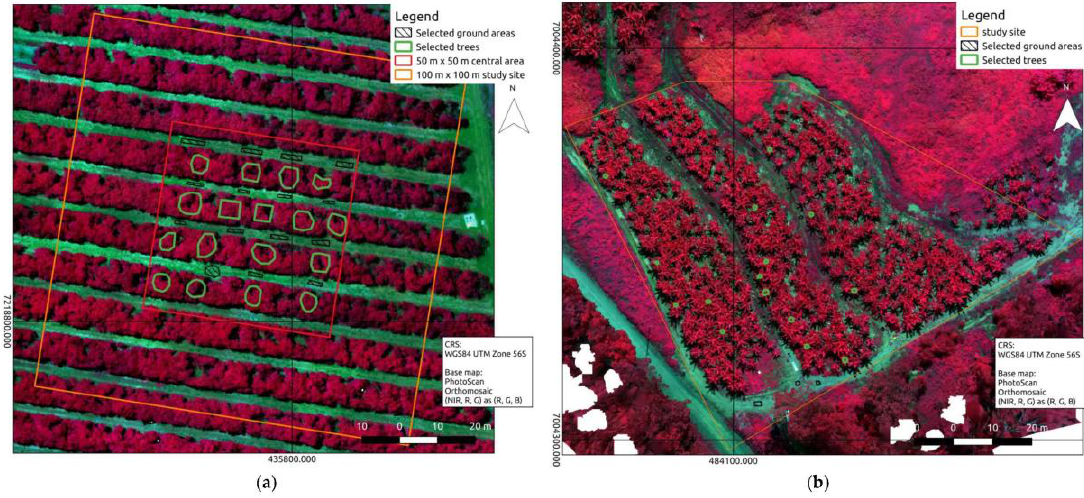
Figure 5. Selected trees and ground areas for both avocado ( a ) and banana ( b ) sites for box-and-whisker